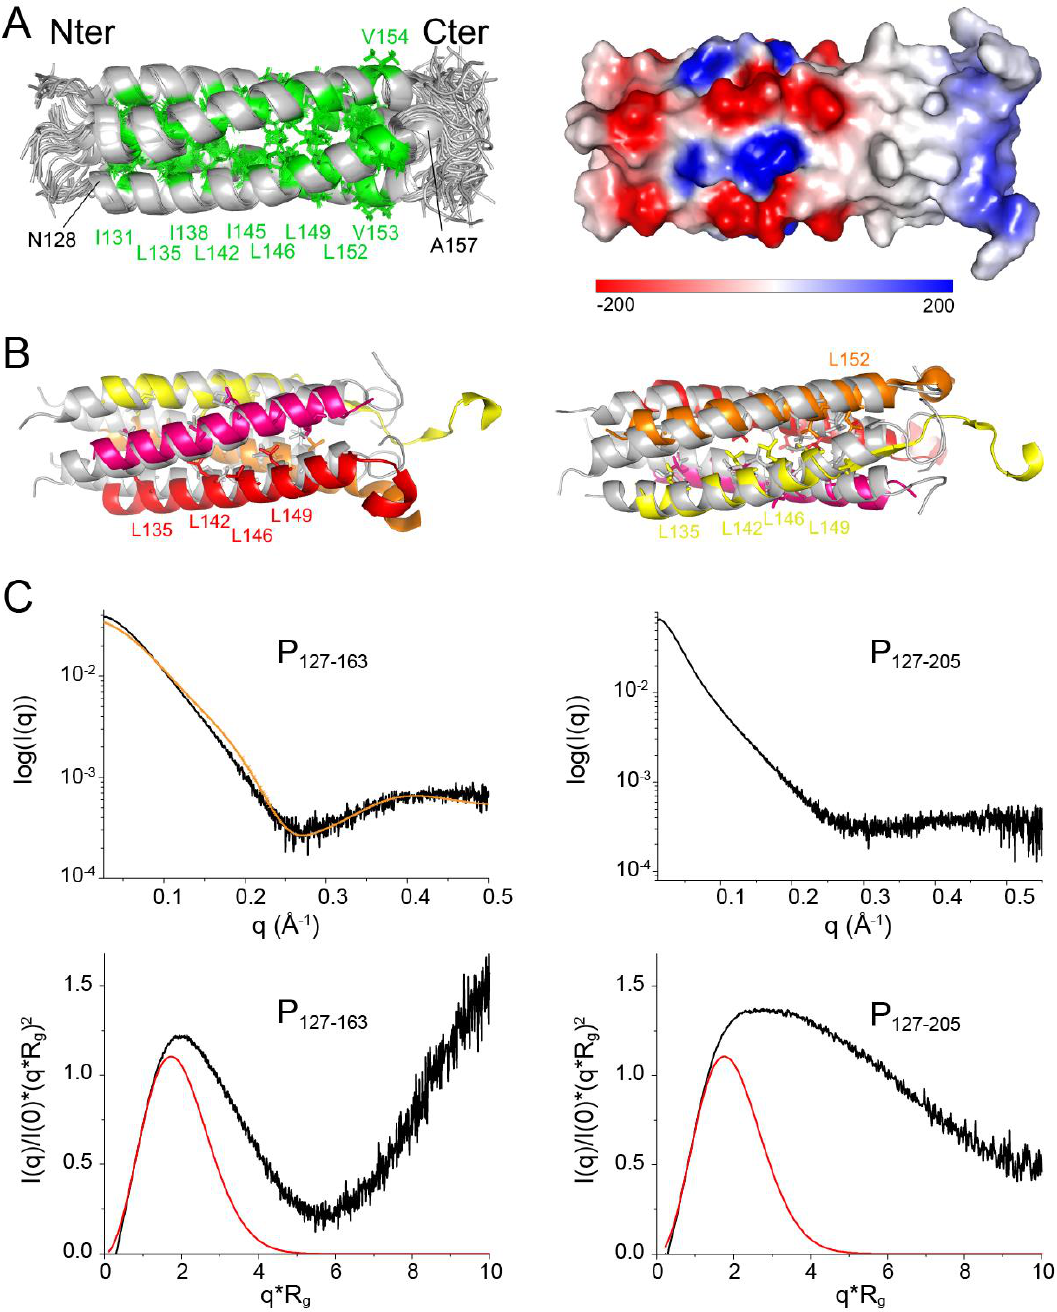
Figure 5. Solution structure of the oligomerization domain of RSV P and dynamics of its C-terminal extensions. ( A ) NMR ensemble structure of RSV P 127–163 . 20 conformer structures calculated with the ARIA software [48] were structurally aligned. Backbones are represented in cartoon and the three hydrophobic residues Ile, Leu and Val in green sticks. The electrostatic surface potential was calculated using the Delphi software [62] . The scale for the ensemble of 20 structures ranges from −200 k B T (red) to + 200 k B T (blue). ( B ) Superimposition of the NMR structure of RSV P 127–163 (conformer 1, in grey) onto the cryo-EM structure of the same sequence in the P—L complex (PDB 6pzk). Each protomer has a different color: yellow, orange, magenta and red. Leucine side chains are shown in sticks. ( C ) SAXS data were measured for P 127–163 and P 127–205 . The scattering intensity curves (log(I) = f(q)), where q is the scattering vector amplitude) are shown. The scattering intensity curve corresponding to the NMR structure of P 127–163 (orange line) was calculated with the FoXs server [55] and superimposed onto the experimental data. Normalized Kratky plots ((q*R g ) 2 *I(q)/I(0) = f(q*R g )) were calculated using the R g and I(0) values obtained with the PRIMUS software [54] : 21.2 Å and 0.0447 for P 127–163 ; 36.8 Å and 0.0749 for P 127–205 . The theoretical normalized Kratky plot for a globular protein is plotted with a red line.